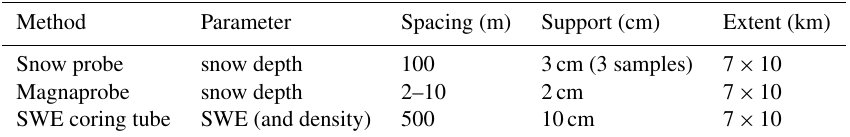
Table 3. Different measurement methods and their approximate spatial scales following the definitions of Blöschl and Sivapalan (1995). Spacing refers to the distance between the samples, support to the diameter of the individual sample, and extent to the overall areal coverage of the measurements.